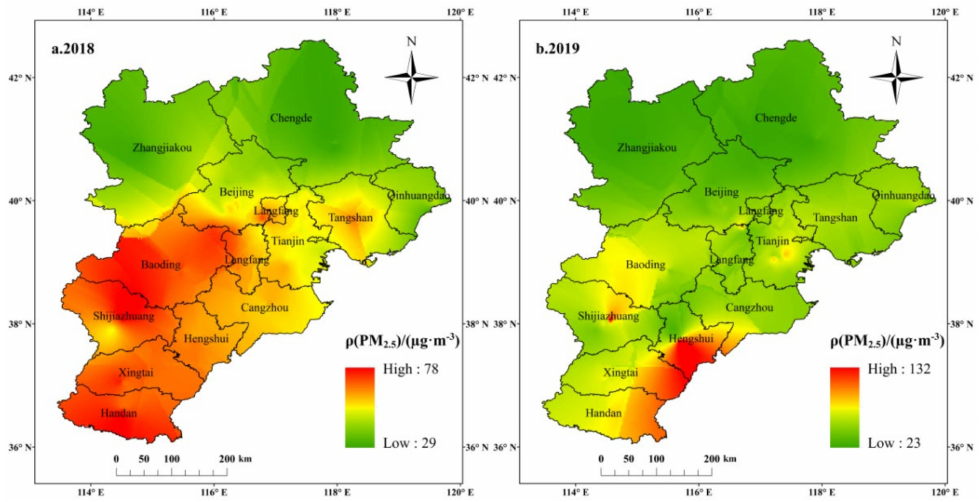
Figure 7. Spatial distributions of the average annual PM 2.5 concentrations across the Beijing-Tianjin- Hebei region in ( a ) 2018 and ( b ) 2019.